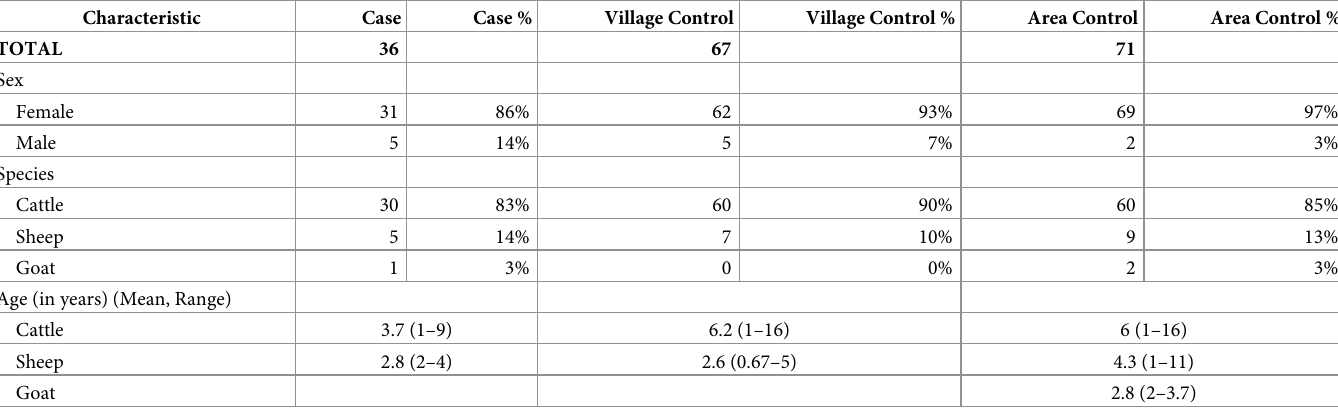
The majority of cases occurred in 2013 (n = 22, 61%); 12 cases (33%) were confirmed and enrolled in 2014, and 2 cases (6%) in 2015 (Fig 1). Cases occurred sporadically throughout the year, but they peaked from August to October.